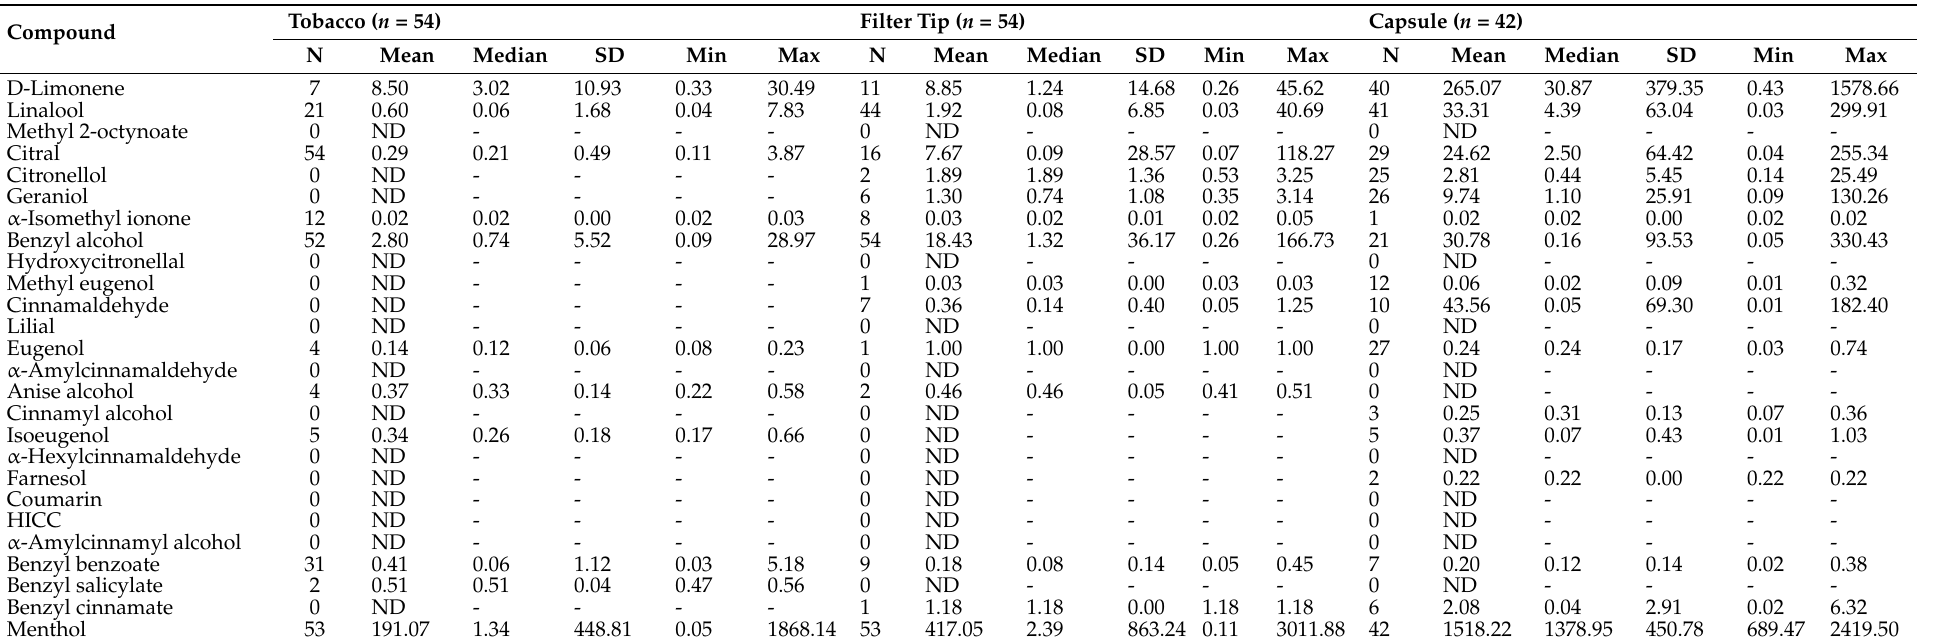
Table 1. Content ( µ g/cigarette) of flavoring agents in tobacco, filter tips, and